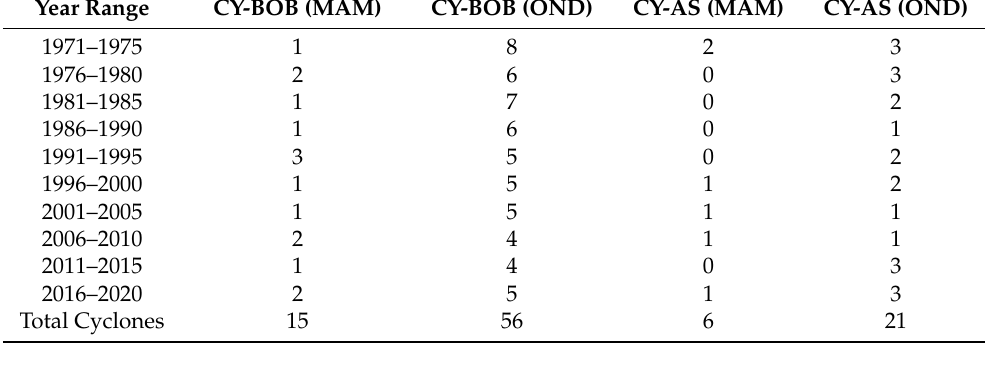
Table 1. Number of cyclones from 1971 – 2020 at intervals of 5 years.